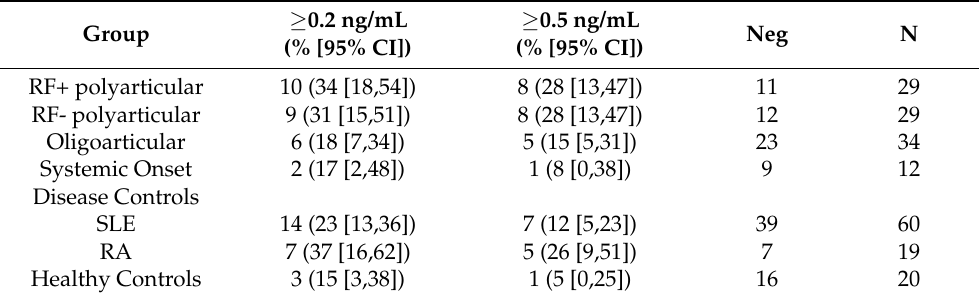
Table 2. Values of 14-3-3 η by group.